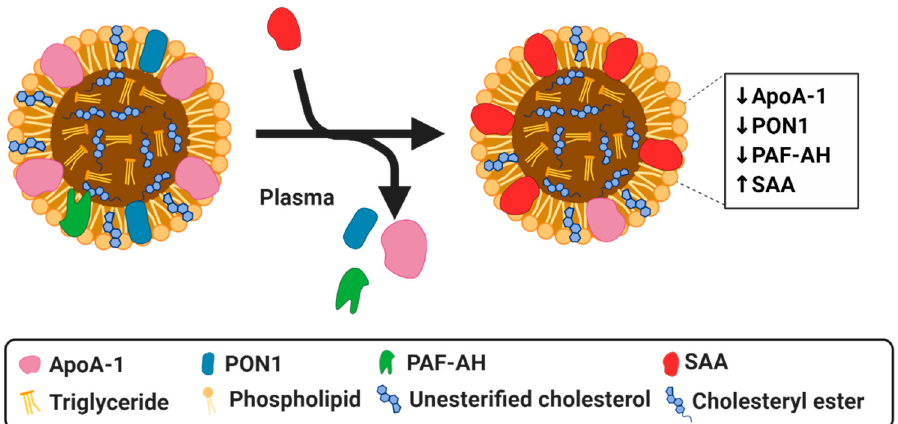
Figure 2. Simplified diagram of serum amyloid A (SAA) modified HDL particle resulting in a dysfunctional HDL. SAA can displace apoA-I, PON1 and PAF-AH.